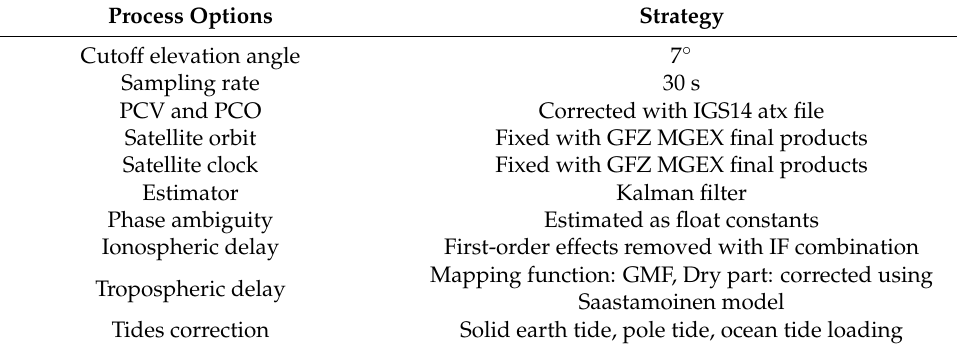
Figure 1. Geographical distribution of the selected 143 worldwide MGEX tracking stations. Table 1. Processing strategy for system combination